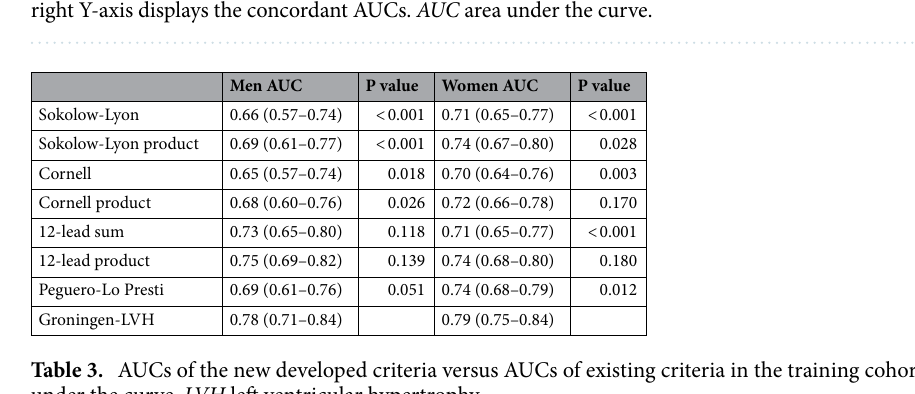
Figure 3. Pseudo R 2 s (orange square for women, blue round for men) and AUCs (pink triangle for women, green triangle for men) of the generated models including all possible sums of amplitudes in logistic regression analyses on LVH. On the X-axis the number of amplitudes added in each model is displayed. On the left Y-axis, the pseudo R 2 s of these models in a logistic regression analyses on CMR determined LVH are reported. The right Y-axis displays the concordant AUCs. AUC area under the curve.